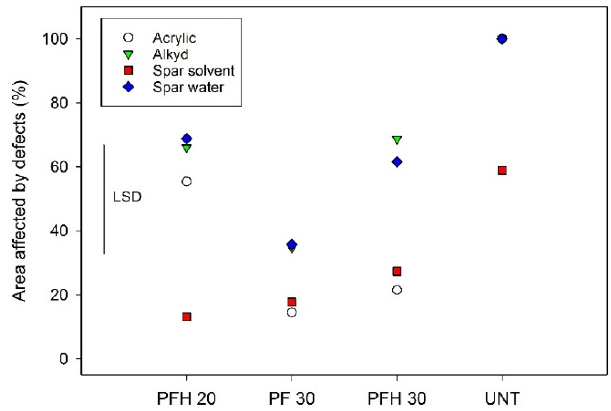
Figure 10. Levels of coating defects in treated and untreated red oak panels after 4 years’ exposure.